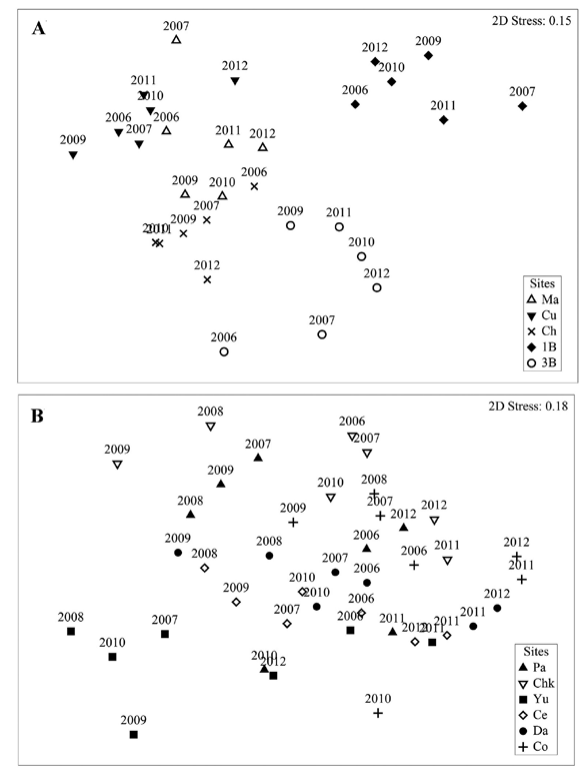
Fig. 4. – NMDS results displaying the similarity of coral assemblag- es at Cancún (A) and Cozumel (B) during the period 2006-2012. Ma, Manchones; Cu, Cuevones; Ch, Chitales; 1B, primer barrera; 3B, tercer barrera; Pa, Paraíso; Chk, Chankanaab; Yu, Yucab; Ce, Cedral; Da, Dalila and Co,